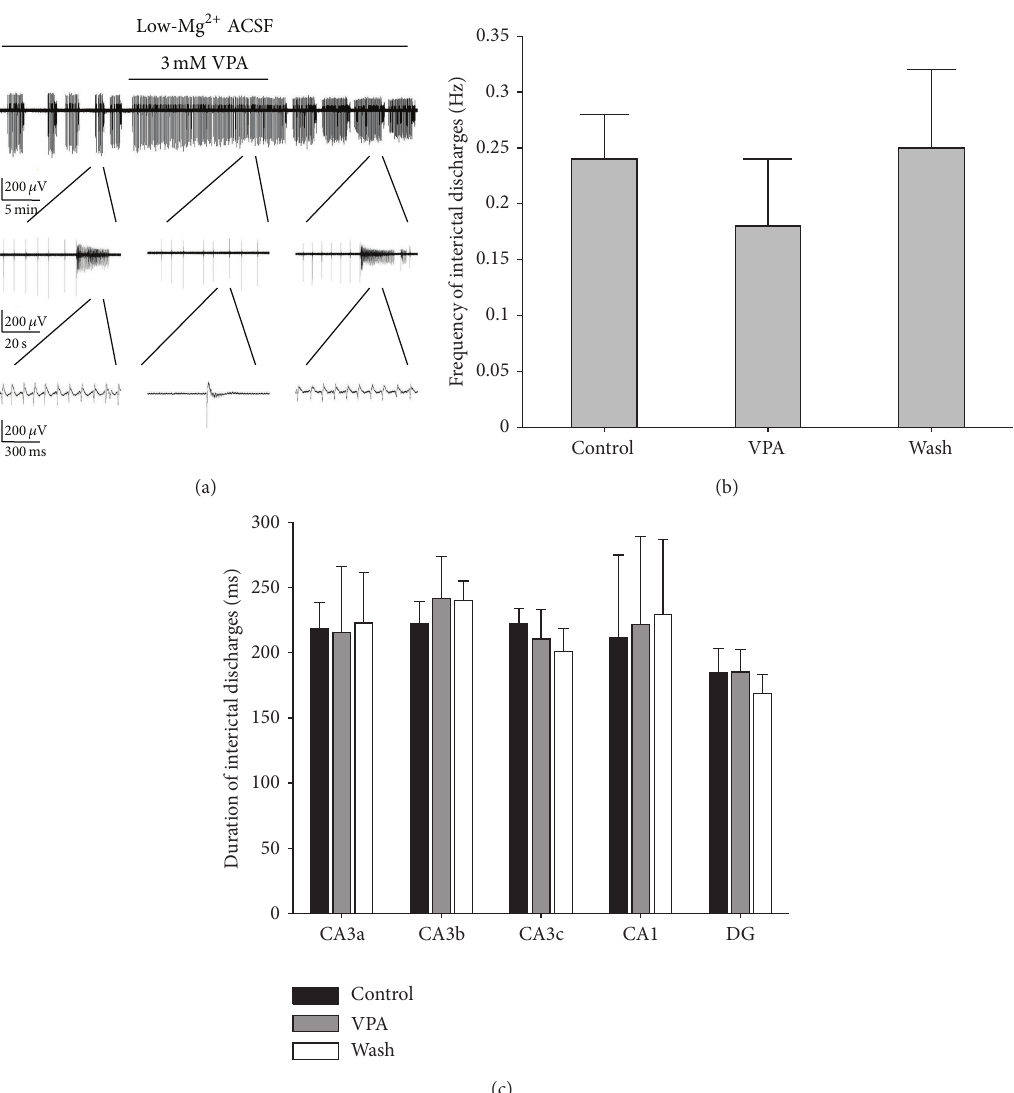
Figure 8: Effects of 3 mM VPA on low-Mg 2+ -induced epileptiform discharges in the hippocampal area of combined slices. (a) Long-term display of low-Mg 2+ -induced epileptiform discharges before, during, and after VPA application, which represents the recordings of electrode number 67 in the CA3b region (Figure 1(d)). (b) Effects of 3 mM VPA on interictal discharge frequency. There are no significant differences between the VPA group and the Control/Wash ( 𝑃 > 0.05 , ANOVA, 𝑛 = 5 ). (c) Effects of 3mM VPA on interictal discharge duration. There are no significant differences between the VPA group and the Control/Wash ( 𝑃 > 0.05 , ANOVA, 𝑛 = 5 ).